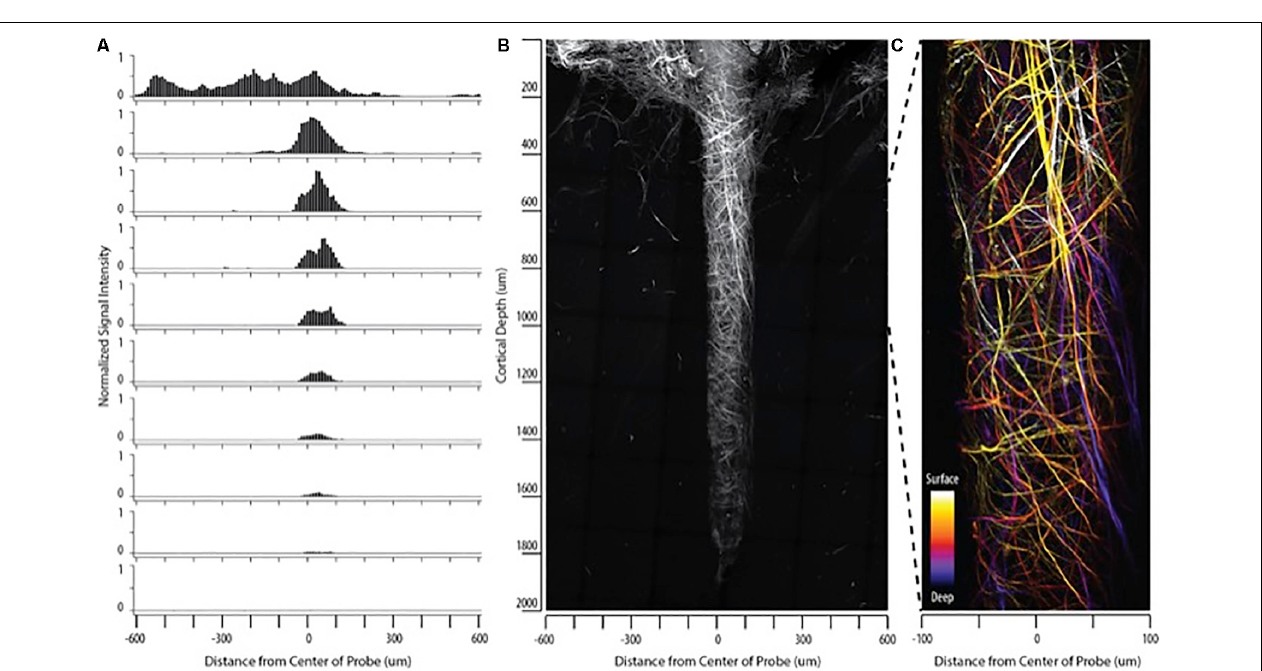
FIGURE 2 | Collagen fibers encapsulate indwelling neural devices. Abundant collagen fibers are shown with SHG imaging (890 nm excitation 445/40 nm emission) of a 132 um NeuroNexus silicon device, implanted for 56 days, captured within a coronal slice of rat brain tissue. (A,B) Quantify and visualize, respectively, that collagen fibers are only observed on the surface of the device, not in the surrounding parenchyma. (C) Magnifies a 500 um × 200 um segment of the image, clearly showing fibers encircling the device as well as extending along the length of the device. When the depth of the collagen within the imaged z-stack is encoded as color (shallow z-depth, surface of tissue slice = white; deep z-depth, interior of tissue slice = indigo), circumferential fibers can be observed both above below longitudinal fibers.